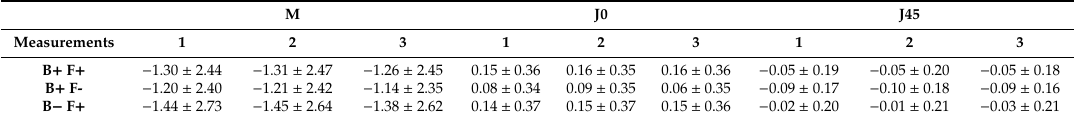
Table 2. Refractive values obtained with each autorefractor. M J0 J45 The values represent average ± 1 standard deviation. All values are expressed in dioptres. B + F + : binocular with fogging. B + F − : binocular without fogging. B − F + : monocular with fogging. M: spherical equivalent. J0 and J45: cylindrical vectorial components.